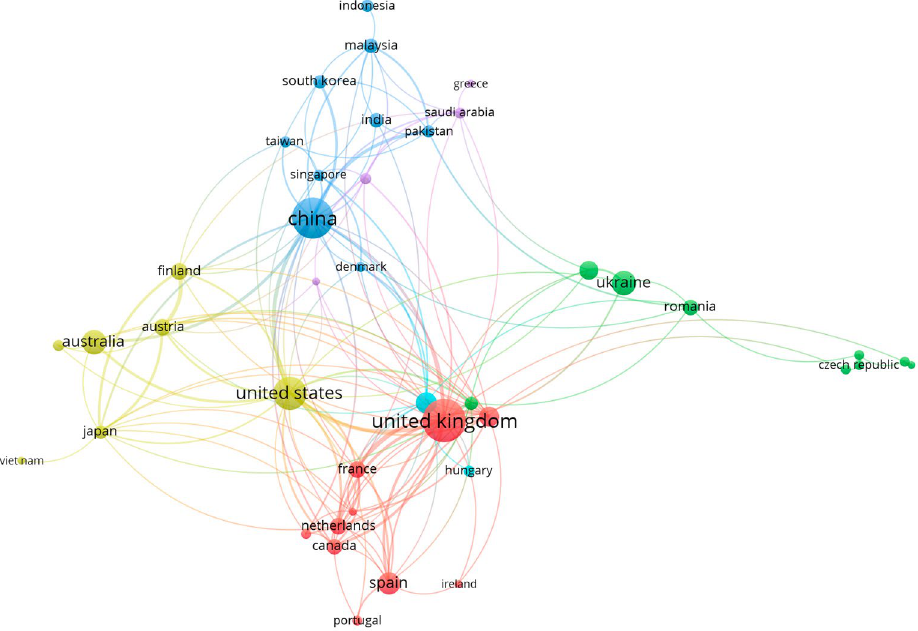
Figure 3. The visualization network of co-authorship analysis in researching DDE by the